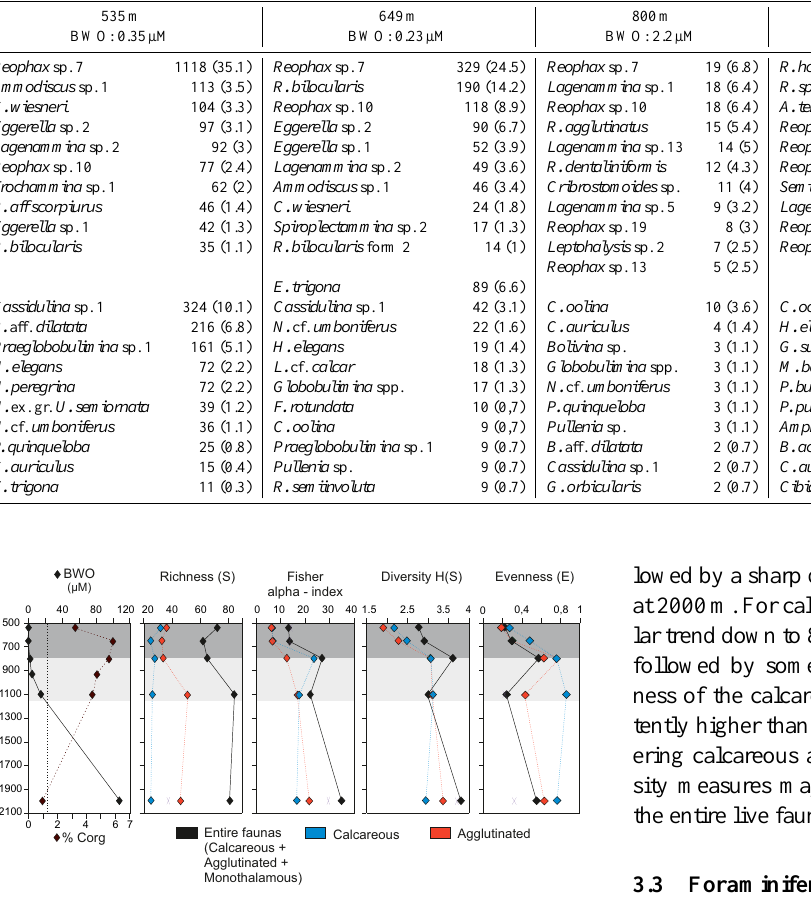
Figure 3. Stained foraminiferal diversity indices (in the >150µm fraction) along the sampling transect. The C org content (wt.%) is from Hunter et al. (2012) and Cowie et al. (2014). The dashed line corresponds to the 22µM limit defining an OMZ according to Levin et al. (2003). The dark-grey shadow represent the core of the OMZ (<2µM; Paulmier and Ruiz-Pino, 2009) and the light-grey shadow the lower part of the OMZ (2–22µM; Levin,